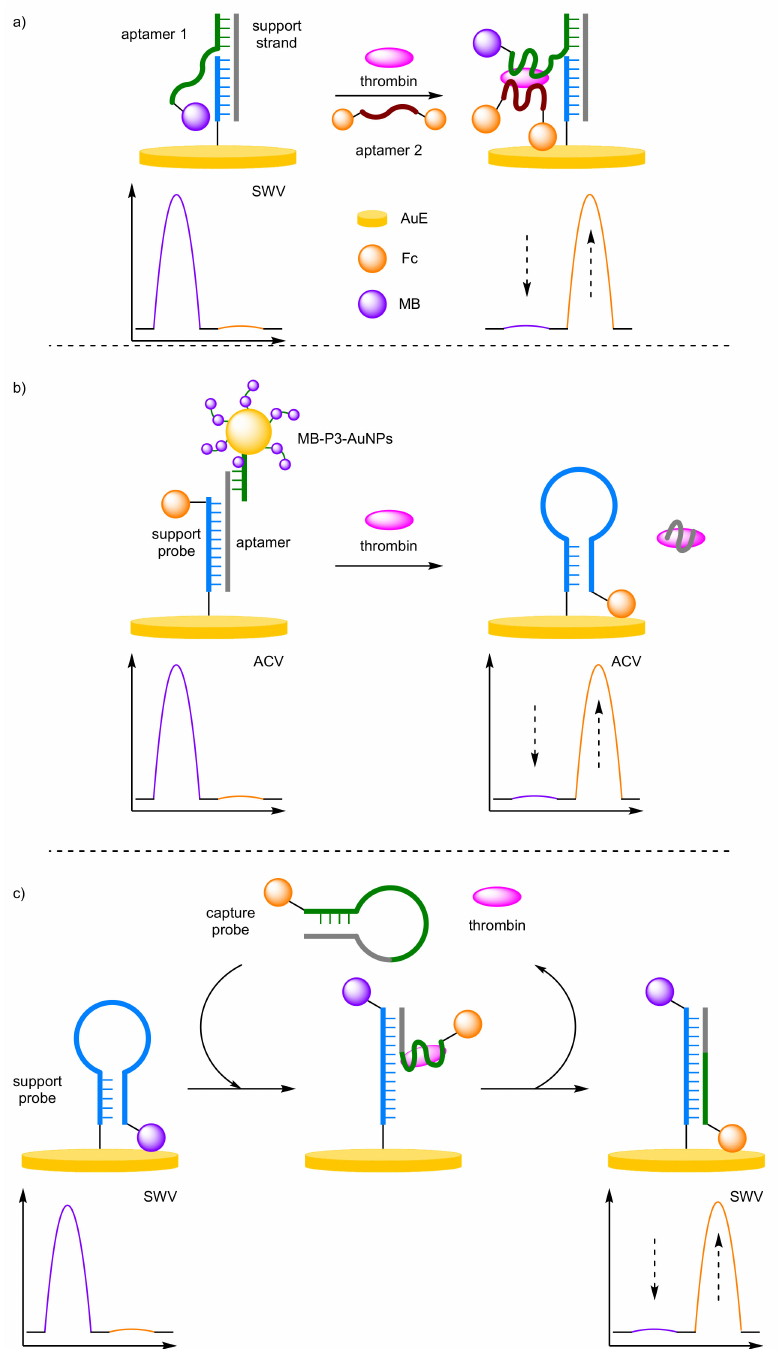
Figure 14. Schematic representation of three biosensors for the detection of thrombin: ( a ) non-amplified aptasensor; ( b ) label amplification-based aptasensor; ( c ) target amplification-based